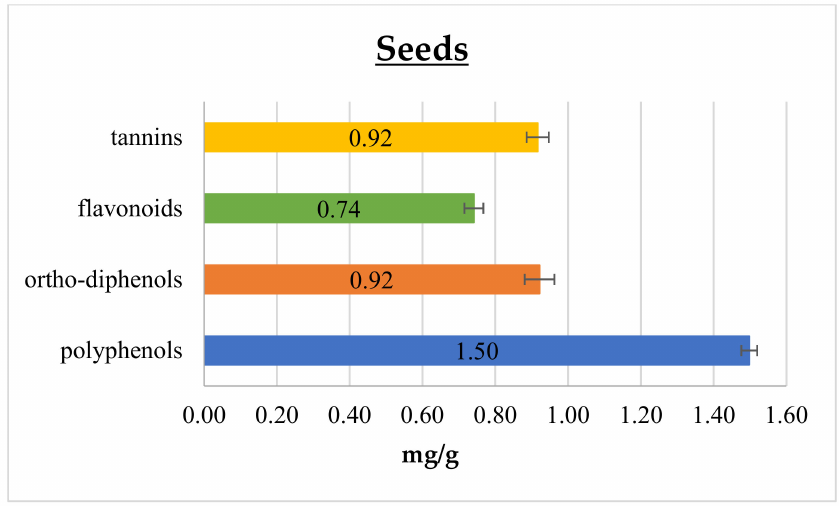
Figure 1. Polyphenol, ortho -diphenol, flavonoid, and tannin contents in cantaloupe peels.